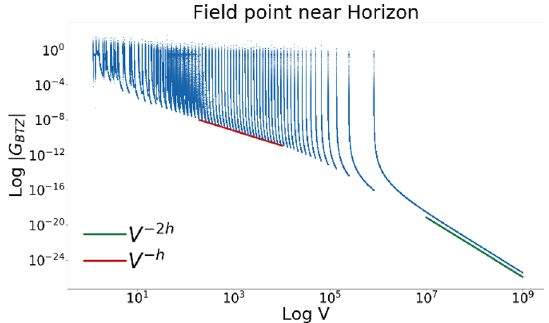
Figure 5 . Illustration of transient V (cid:0) h decay before ultimate V (cid:0) 2 h decay for (cid:12)eld points near the horizon. The parameters are the same as (cid:12)gure 4 except we take ( R (cid:0) R H ) =R H = 10 (cid:0) 3